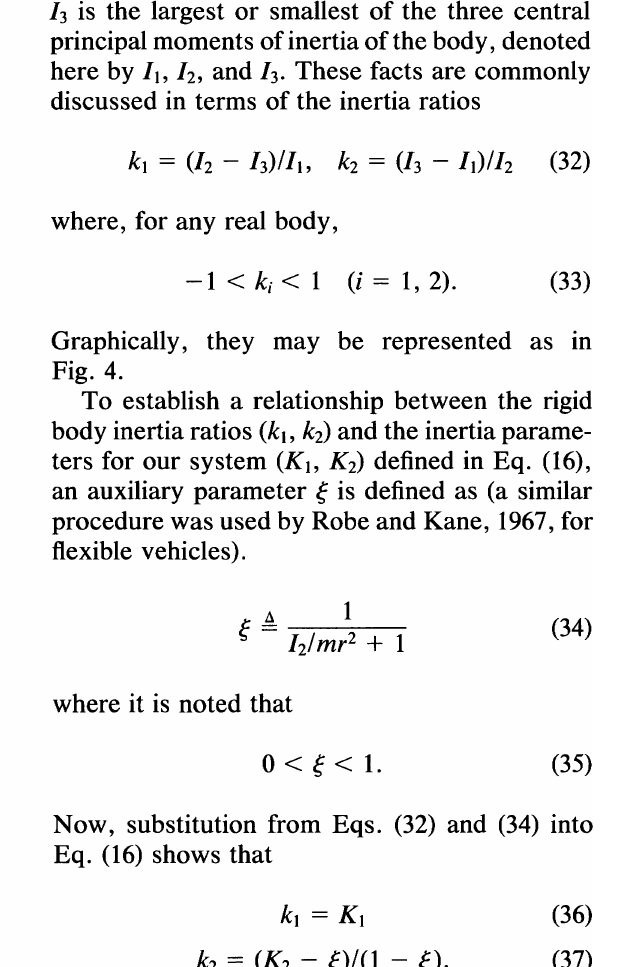
FIGURE 4 Instability chart for a torque-free rigid body with one fixed